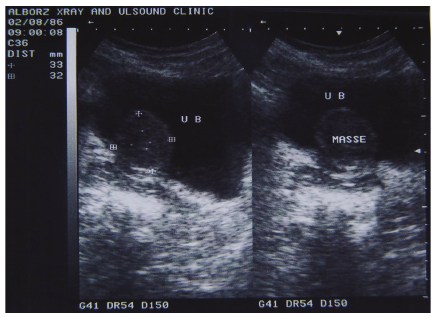
Figure 1: A heteroechoic round mass was revealed in ultrasonogra- phy.